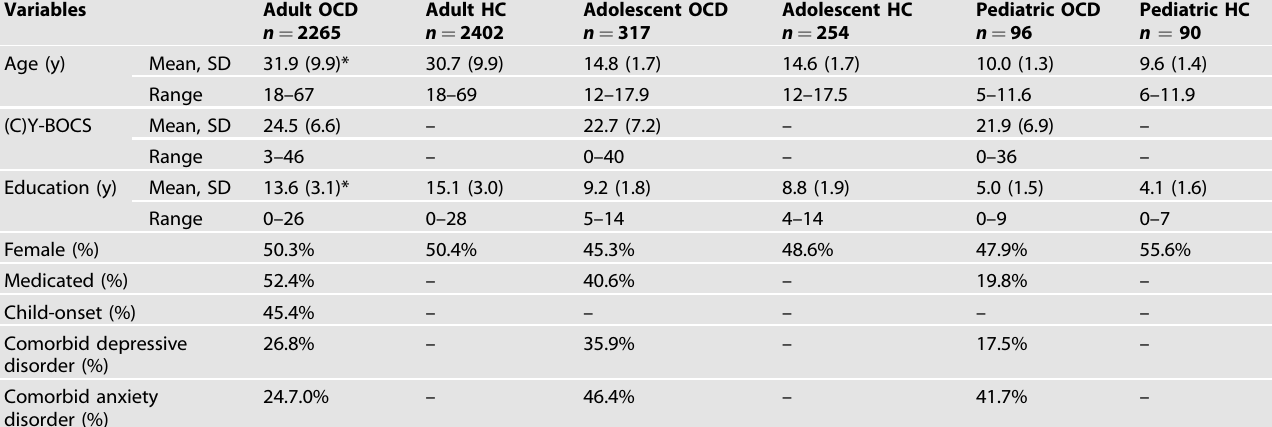
Table 1. Pooled descriptive statistics of obsessive-compulsive patients and healthy control participants for the adult (age 18 or higher), adolescent